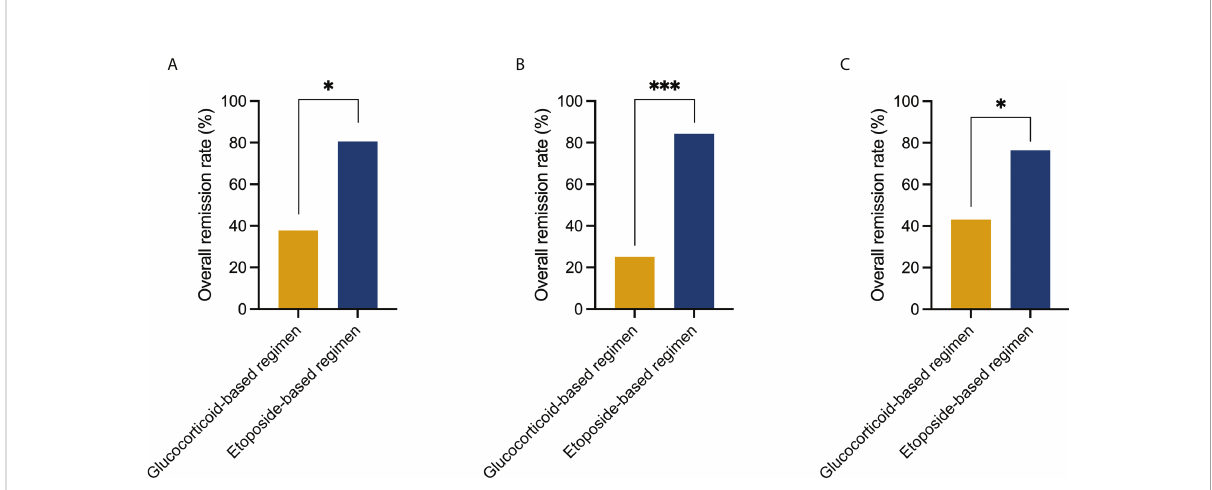
FIGURE 1 Comparison of treatment response to the glucocorticoid-based regimen and etoposide-based regimen at 2 weeks post initial treatment. (A) Initial use of the etoposide-based regimen induced a higher overall remission rate than the glucocorticoid-based regimen in the entire cohort (80.6% vs . 37.8%, P = 0.020). (B) Initial use of the etoposide-based regimen induced a higher overall remission rate than the glucocorticoid- based regimen in patients who had MAS as fi rst manifestation (84.2% vs . 25%, P < 0.001). (C) Initial use of the etoposide-based regimen